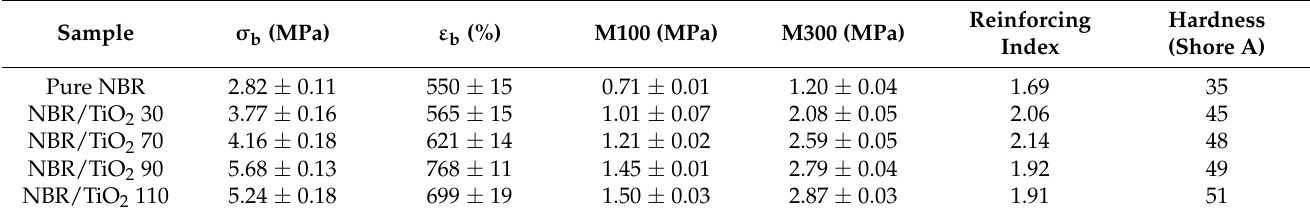
Table 3. Mechanical properties of TiO 2 -filled NBR composites with various TiO 2